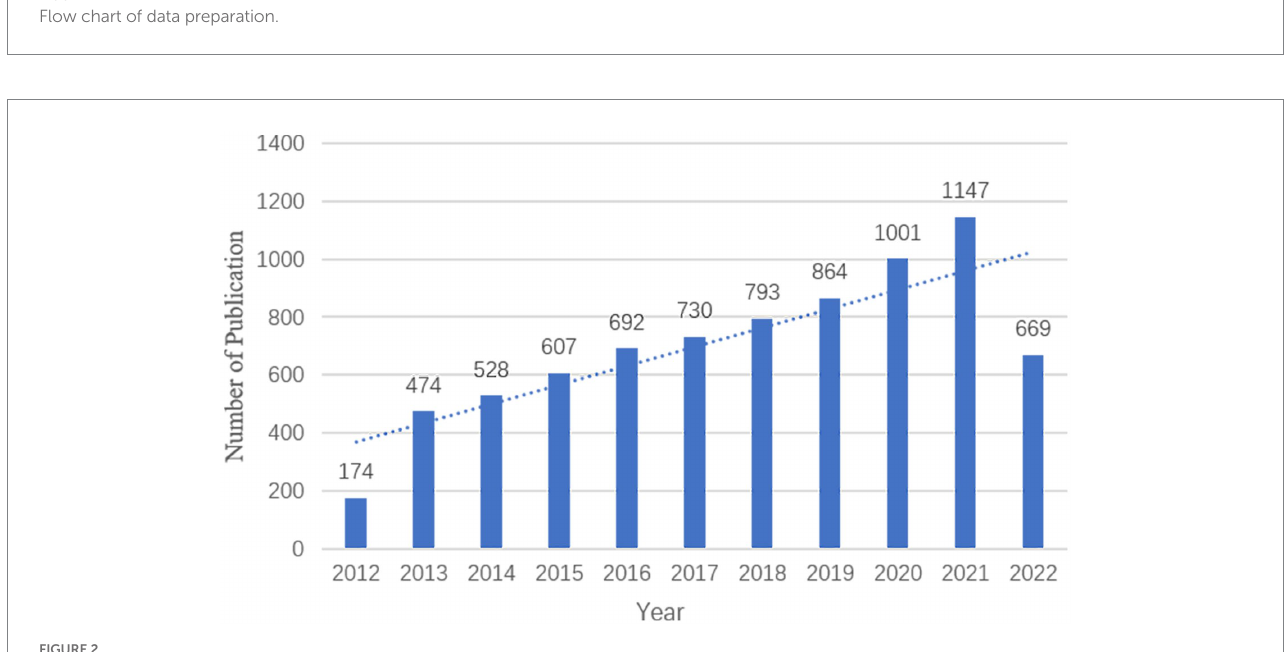
FIGURE 1 Flow chart of data preparation.